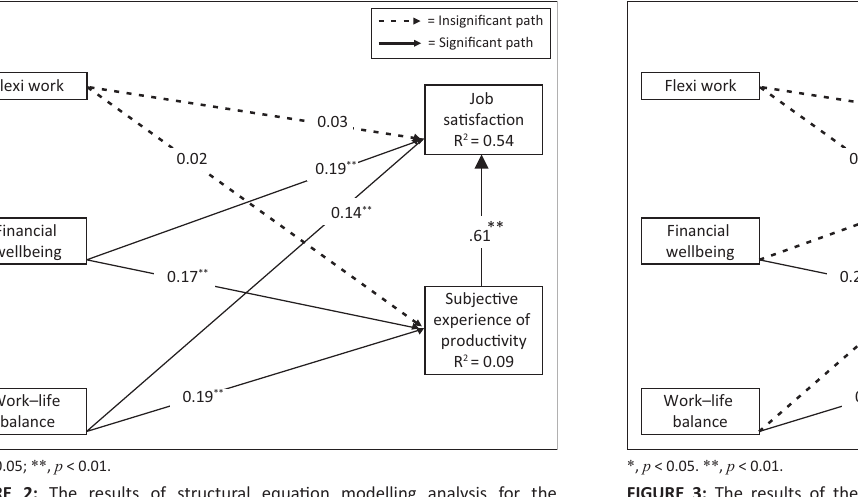
FIGURE 3: The results of the structural equation modelling analysis for the alternative model: Model